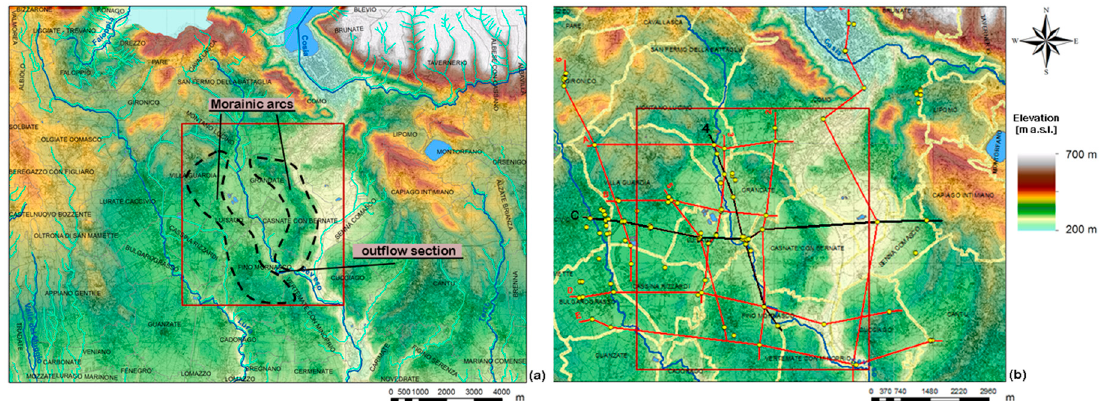
Figure 2. ( a ) Digital Elevation Model of the study area, principal hydrographic network, and model domain (red square); ( b ) stratigraphic logs (yellow dots), and realized cross-section traces (in black Section 4 and C).